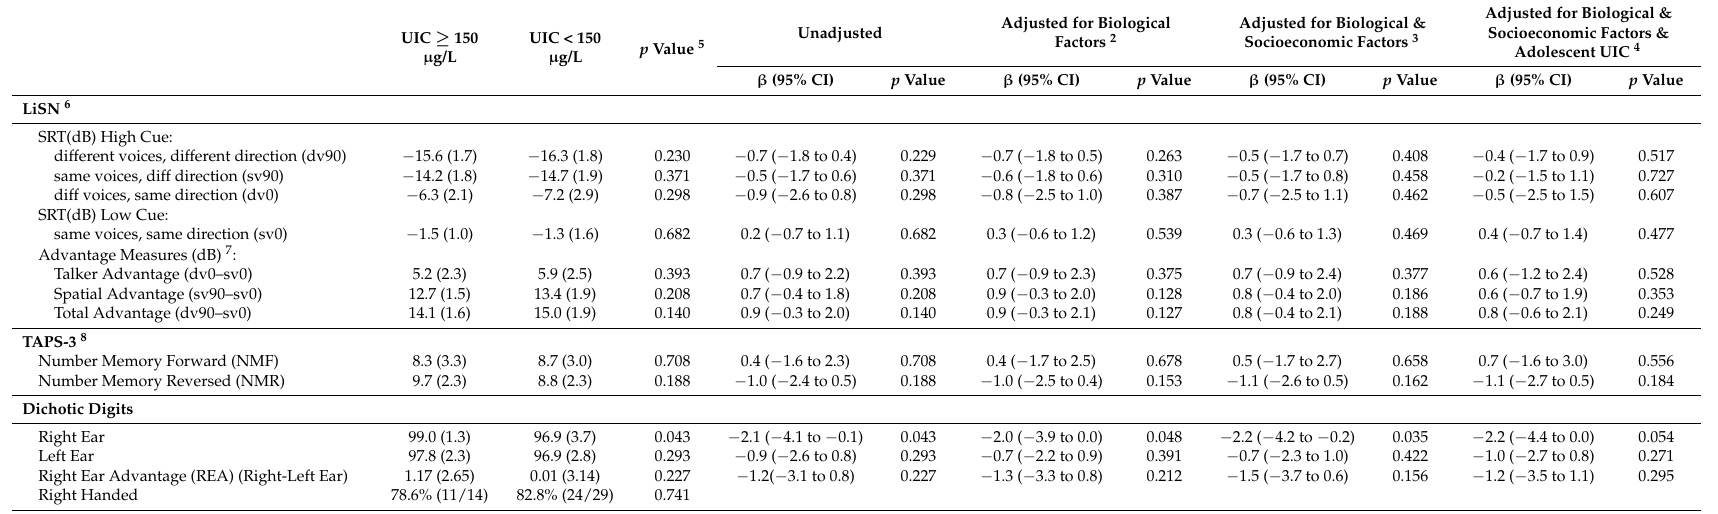
Table 5. CAPD: Differences in outcomes 1 and regression models for offspring of mothers with deficient UIC (<150 µ g/L) ( n = 15) during pregnancy compared to mothers with sufficient UIC ( ≥ 150 µ g/L) ( n =